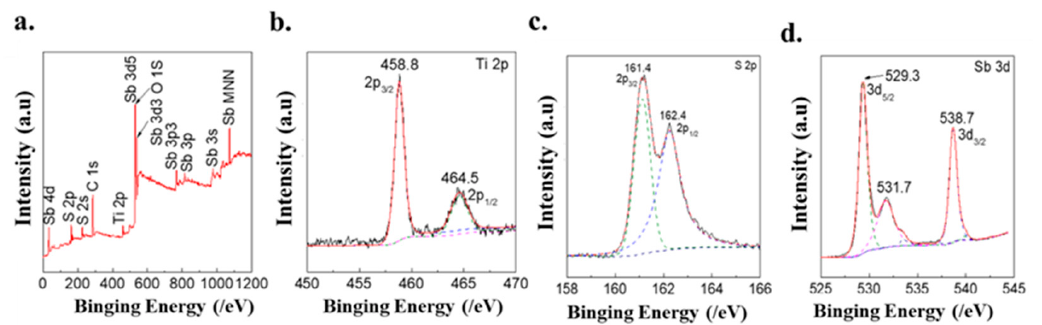
Figure 3. XPS spectra of the Sb 2 S 3 /TiO 2 ; ( a ) survey scan, ( b ) Ti 2p, ( c ) S 2p, and ( d ) Sb 3d, respectively. For the spectra in the Ti 2p, S 2p, and Sb 3d regions, the dashed lines are the deconvoluted spectrum bands, and the solid lines are the spectrum simulated by the deconvoluted bands.